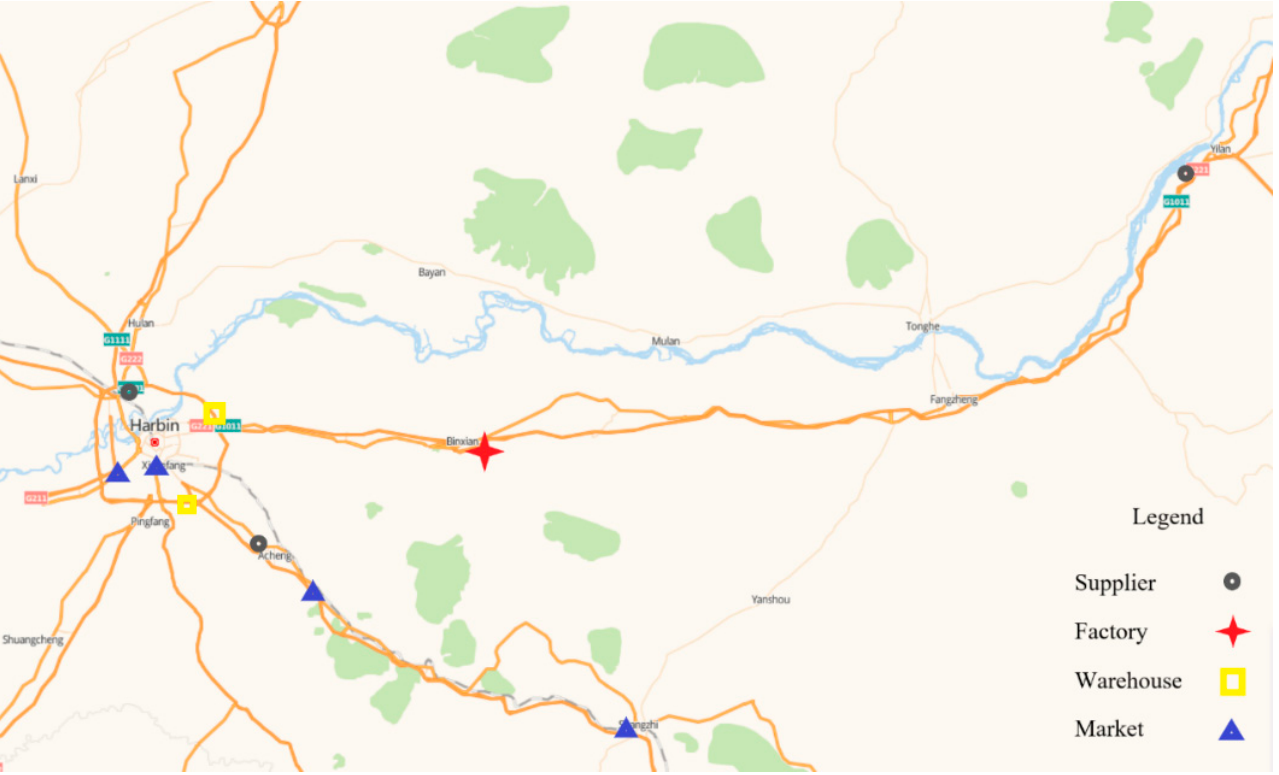
Figure 2. The location of different facilities of the case study.